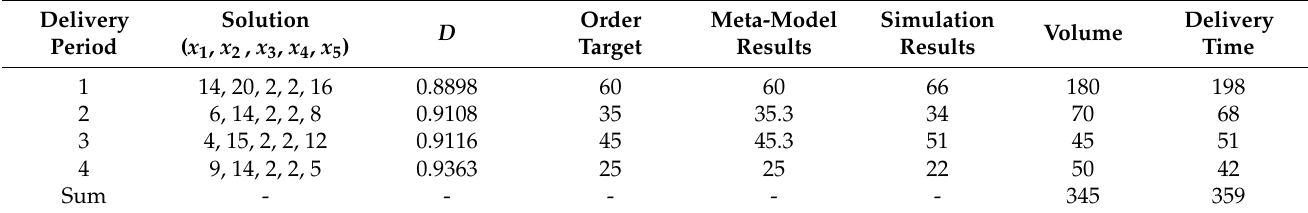
Table 7. Resource Allocation Solution Validation.